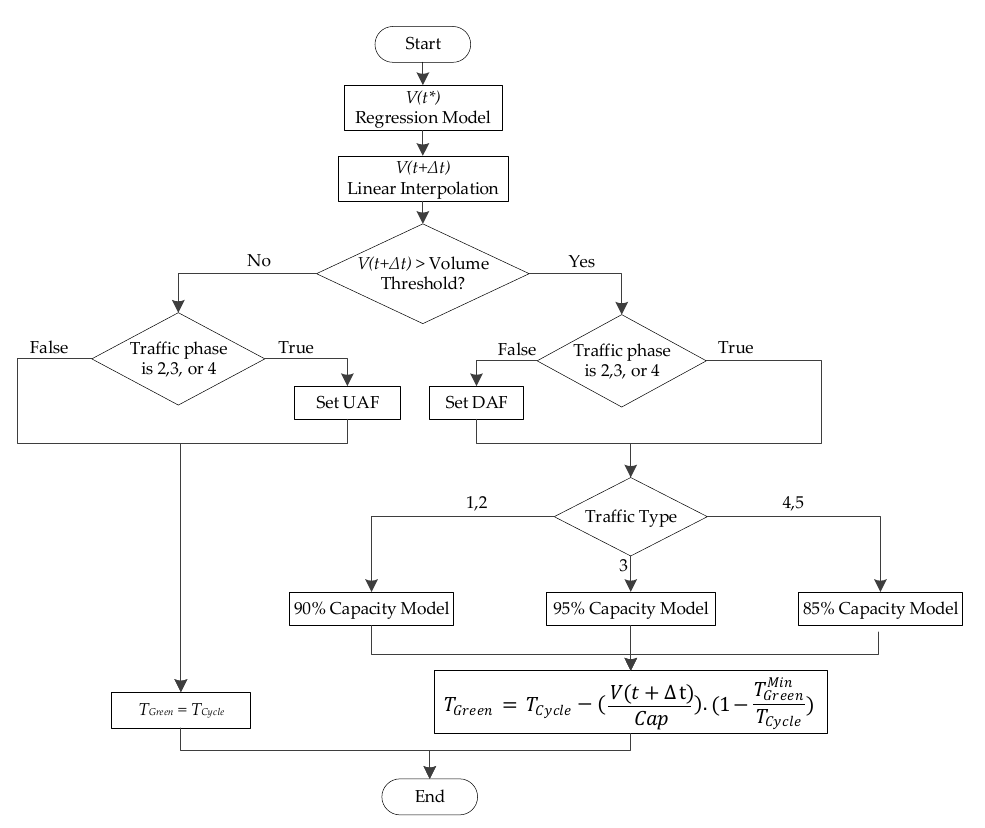
Figure 8. Proposed final ramp meter algorithm schematic.